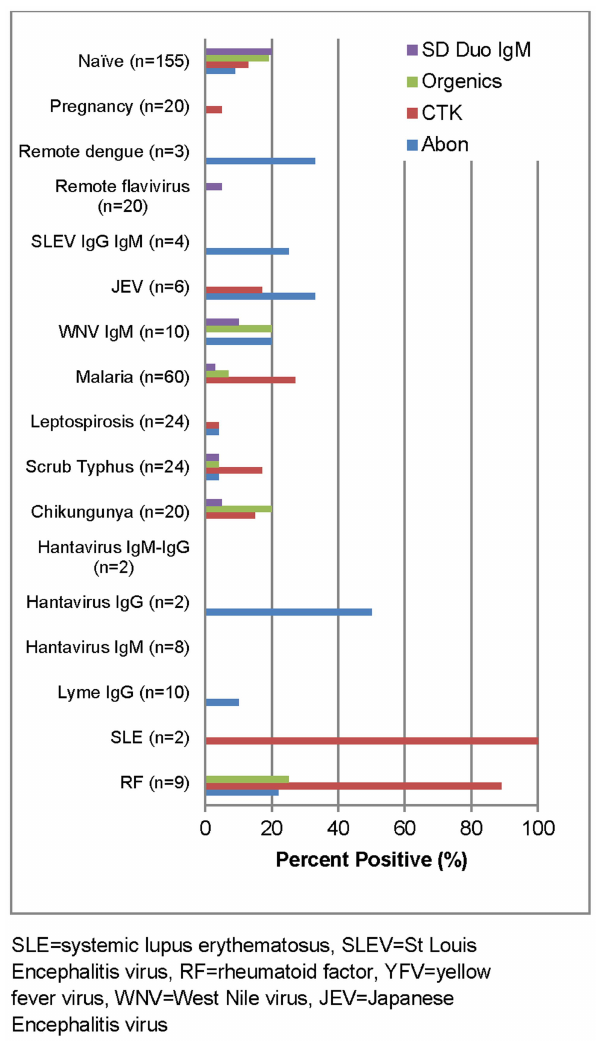
Figure 4. False positive rate of anti-DENV IgM rapid diagnostic tests in DENV negatives and challenge panel specimens.